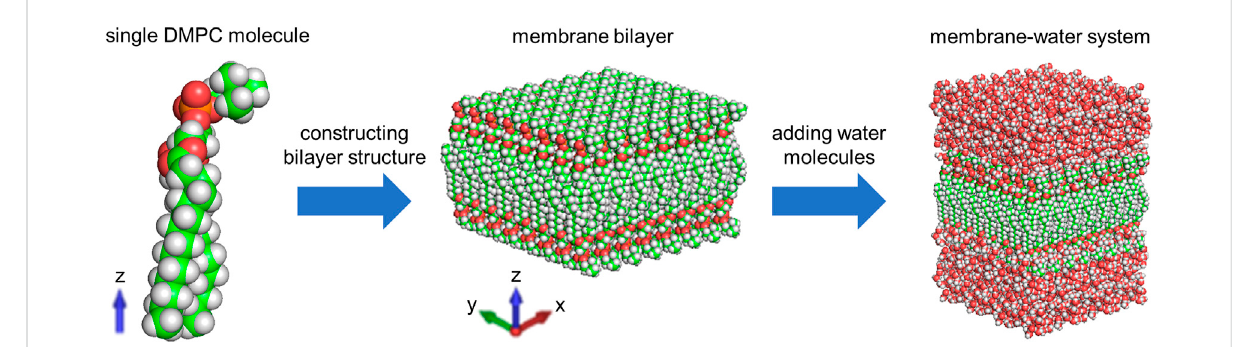
Model of the membrane-water system based on DMPC molecules for the MD simulation.